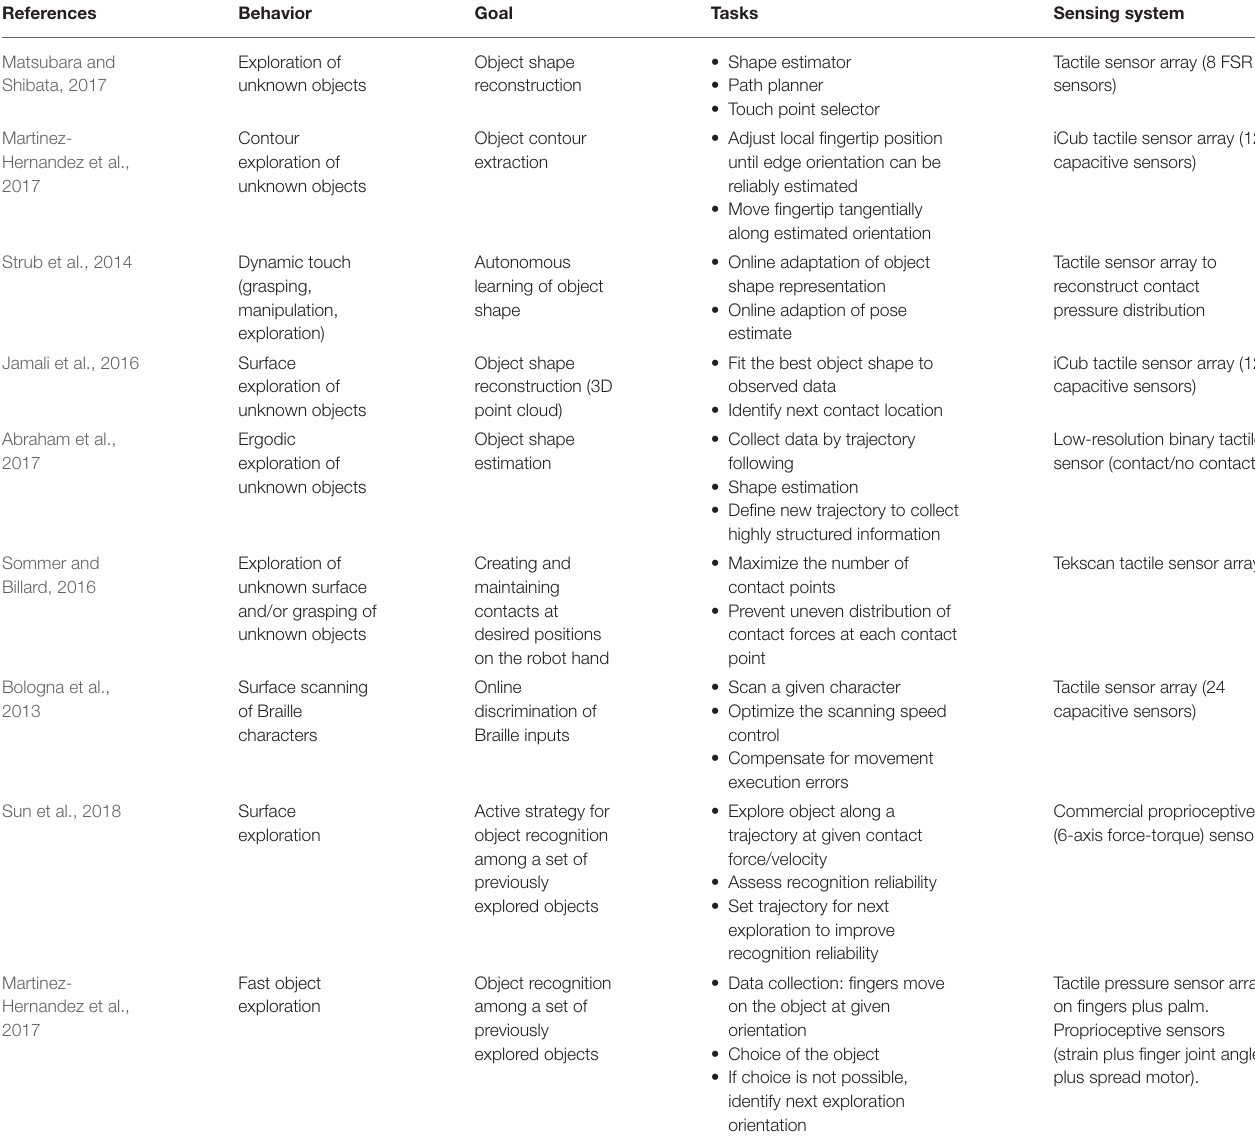
TABLE 1 | Haptic behavior, goal, tasks, and sensing system are specified for each selected use